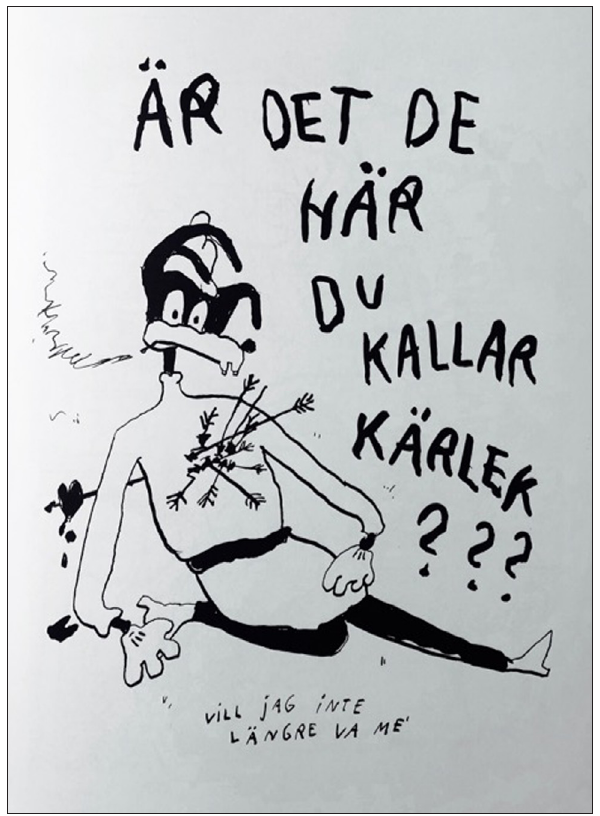
Figure 4: Ester Eriksson (2017) ‘If these are what you call love, I don’t want to be here anymore.’ Jag, Esters rester. Stockholm: Kartago. © Ester